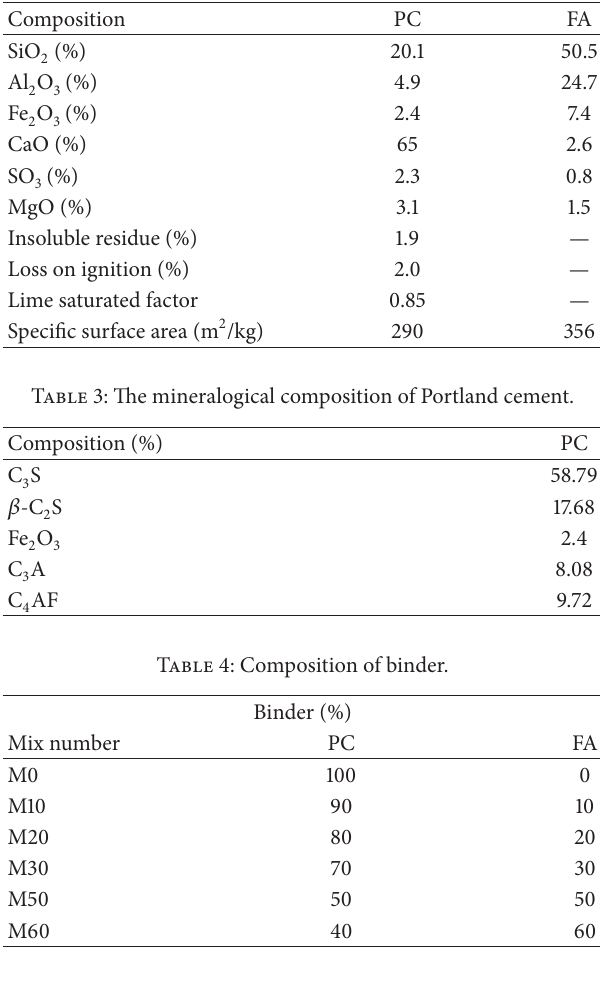
Table 1: Properties of P(2-HEA-co-2-HEMA) [26]. Table 2: Chemical composition of Portland cement and fly ash.